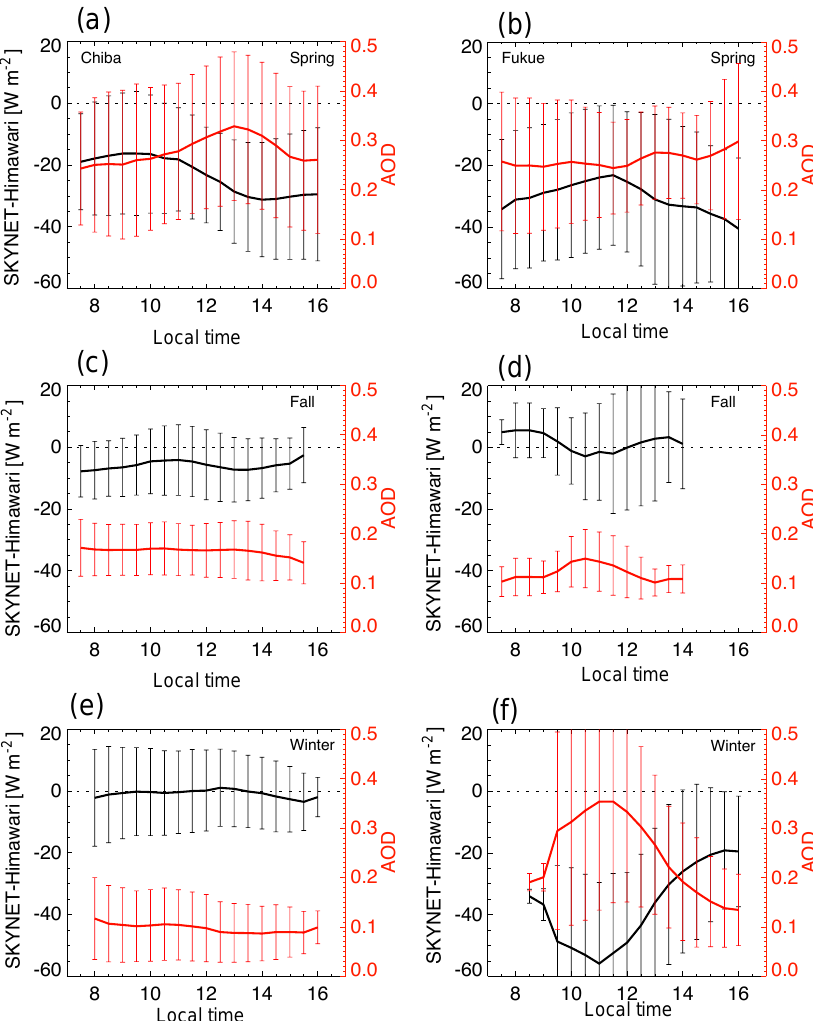
Figure 11. Diurnal variation in the seasonal global radiation difference (i.e., SKYNET data minus Himawari-8 data, black lines) under clear- sky conditions and AOD (red lines on the opposite axis) for (a, b) spring, (c, d) fall, and (e, f) winter at the Chiba (a, c, e) and Fukue (b, d, f) stations. Error bar shows the standard